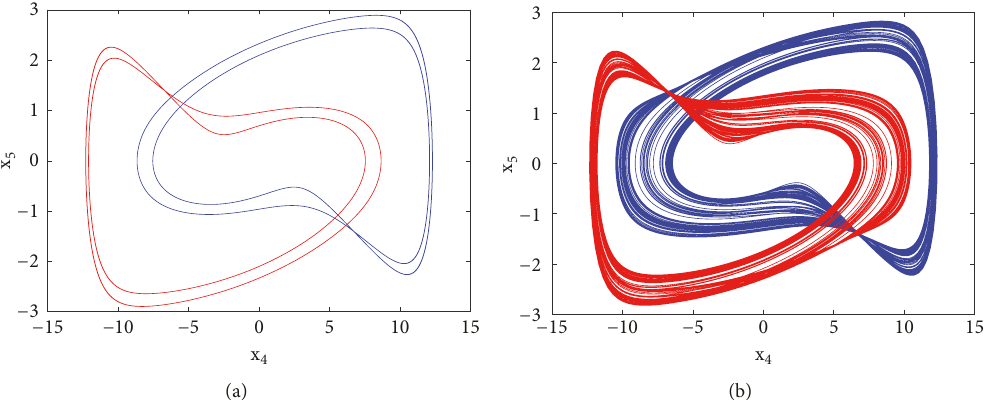
Figure 6: Two-dimensional projections (x 4 -x 5 ) of four coexisting chaotic and periodic attractorsfor b = 29.57, a 0 = a 2 = a 3 , a 1 = 7, a 4 = 5.4433 x 10 −4 . Initial conditions are indicated in Table